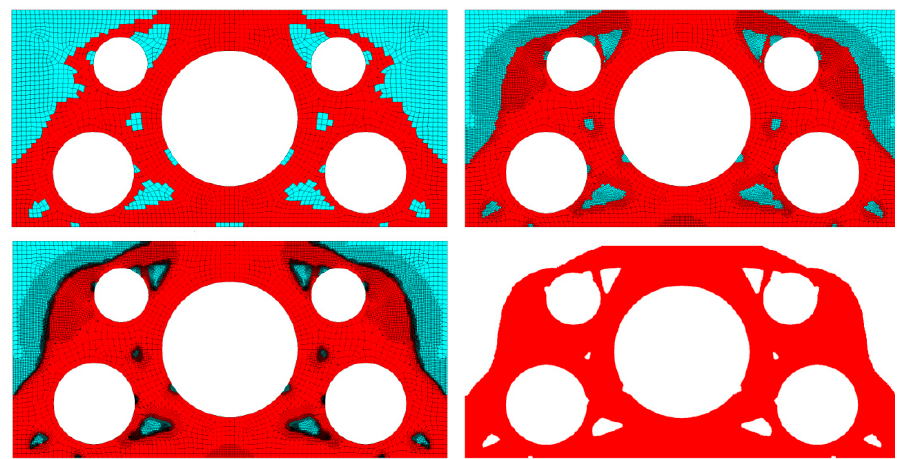
Figure 33. Iteration history for the plane structure with holes. In this case of a mesh with high irregularities, an additional CA rule was introduced; solid elements that are surrounded by voids are converted into voids, and vice versa. This prevents the appearance of sharp details along the edges.